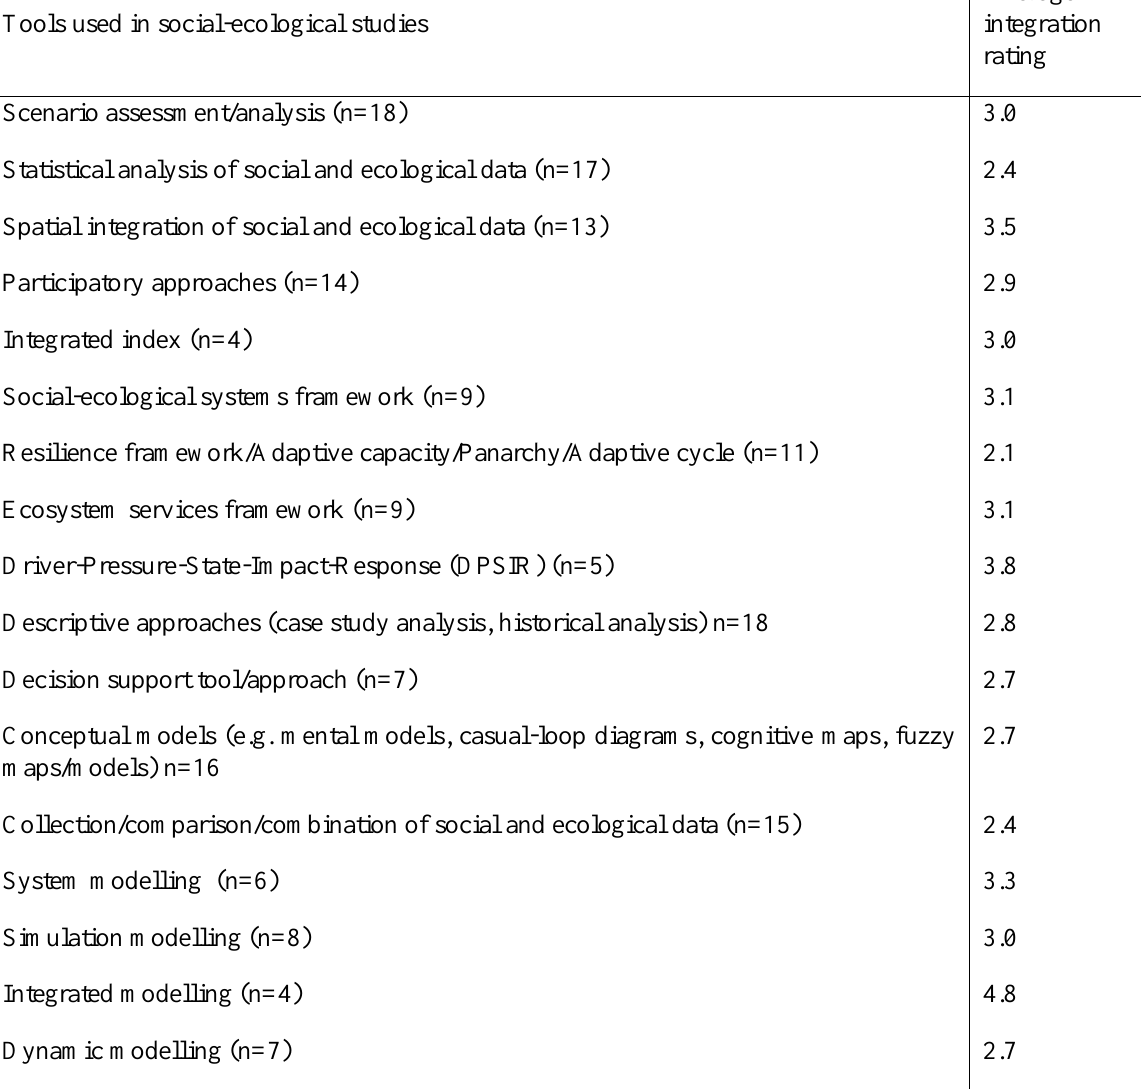
Table A4.3 . Integration rating by tool used Tools used in social-ecological